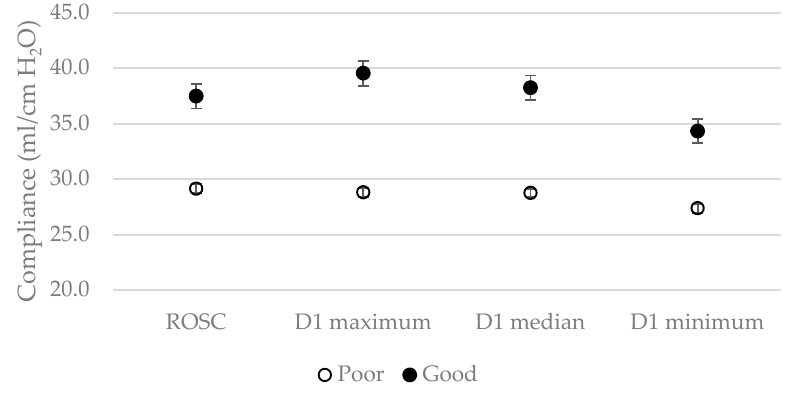
Figure 2. Di ff erences of compliances on day-1 depend on neurologic outcomes. Abbreviations: ROSC = return of spontaneous circulation; D = day. Figure 2. Differences of compliances on day-1 depend on neurologic outcomes. Table 4. Performance of compliance to predict good Abbreviations: ROSC = return of spontaneous circulation; D = day. Table 4. Performance of compliance to predict good outcomes.